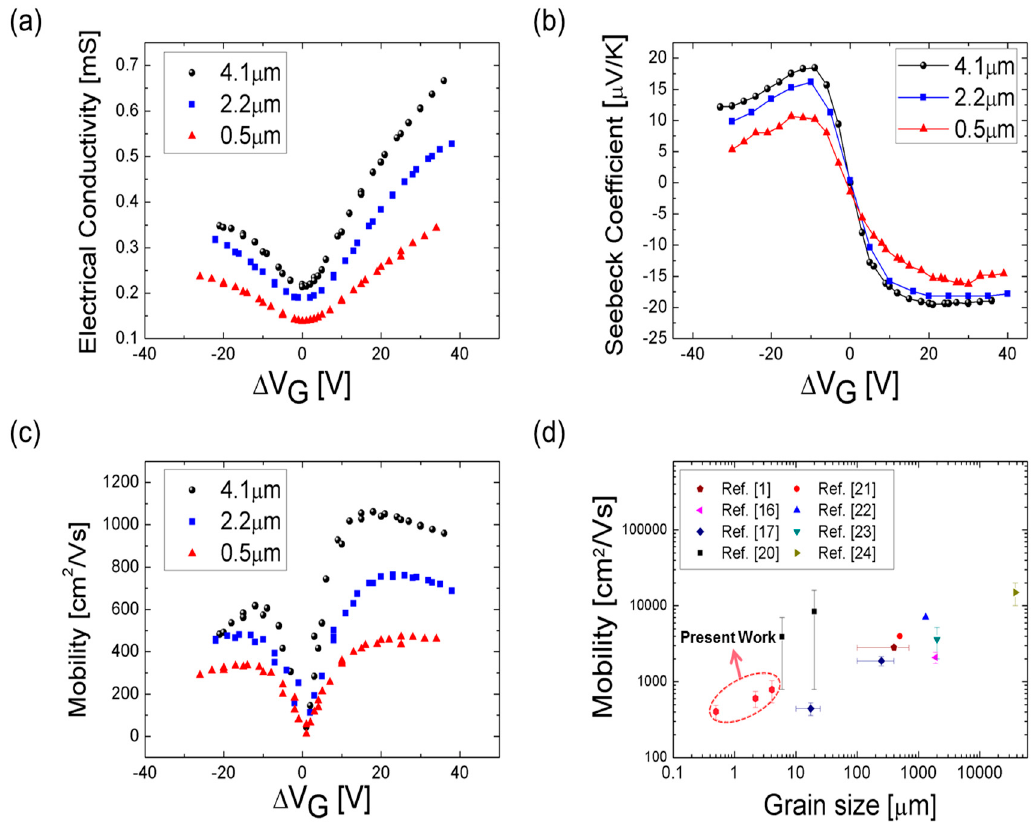
Figure 3. ( a ) Electrical conductivity for the three grain sizes of 4.1 µm, 2.2 µm, and 0.5 µm as functions of the gate voltage sweep. ( b ) Seebeck coefficient for the three grain sizes as functions of the gate voltage sweep. ( c ) Mobility for the three grain sizes as functions of the gate voltage. ( d ) Measured mobility data compared with published data for varied grain sizes.